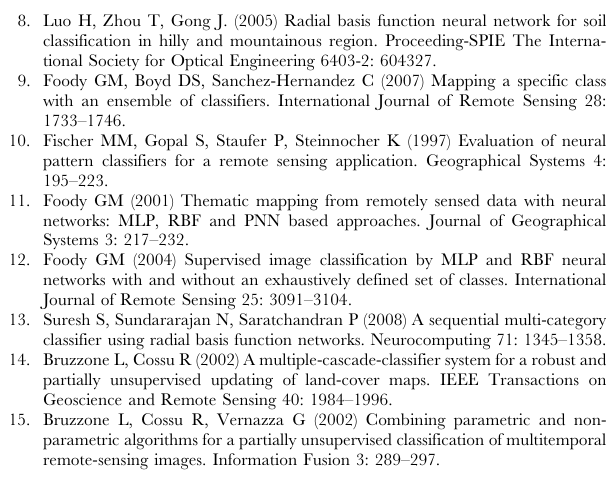
Figure S1 Flowchart of genetic algorithm implementation for AF center and width selection. (TIF) Table S1 Algorithmic settings for classification